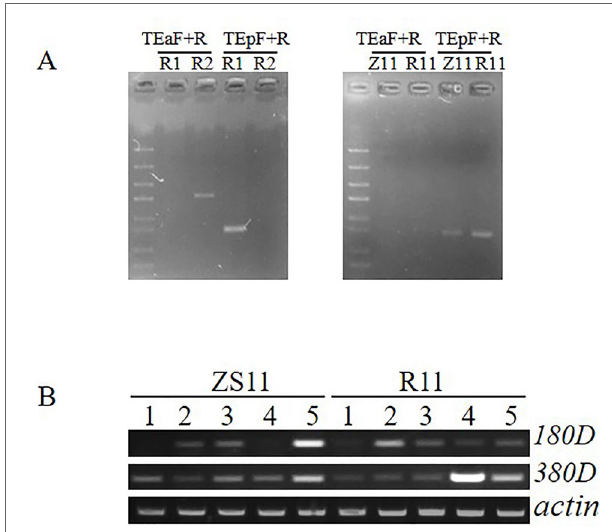
FIGURe 5 | Detection of specific insertion of CACTA-like transposable element (TE) and expression comparison of two candidate genes. (a) The PAV PCR marker was used to detect the presence or absence of the 12.3- kb fragment and the presence or absence of the CACTA-like TE. TEa-F and TE-R specifically detect the presence of the 12.3-kb fragment and the absence of the TE, and the combination of TEp-F and TE-R specifically detects the presence of the TE and the absence of the 12.3-kb fragment. (B) Expression analysis between ZS11 and R11 in five tissue samples. 1 leaf, 2 stem, 3 flower bud with 2–2.5 mm, 4 flower bud with 3–3.5 mm, 5 young